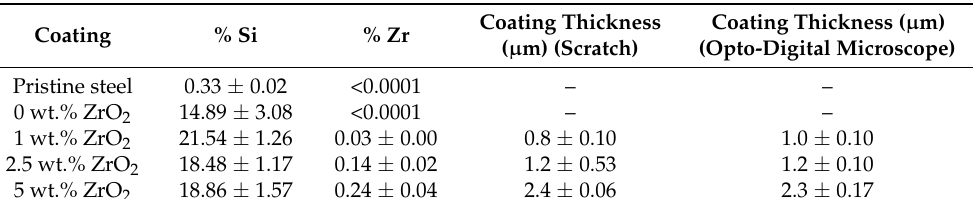
Table 2. Analysis of the composition and estimated thickness of the coatings for the different ZrO 2 percentages by XRF and scratch and roughness measurements, respectively.